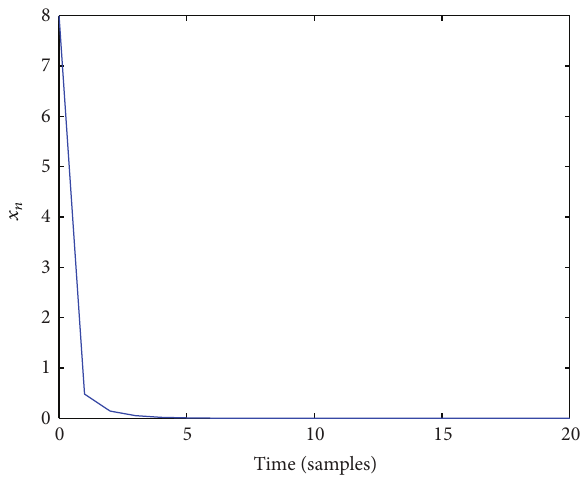
Figure 7: Convergence of the iterates to zero for time-varying weights given by (39).